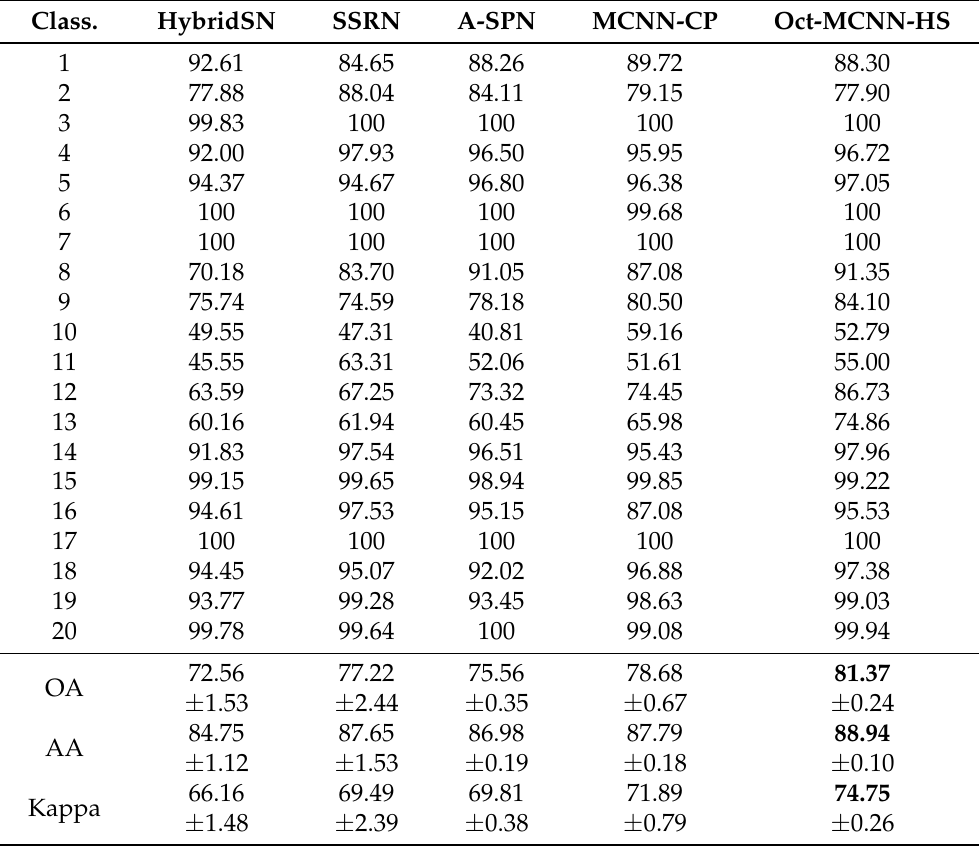
Table 7. Results (%) for the University of Houston dataset with 2000 training samples. Class.